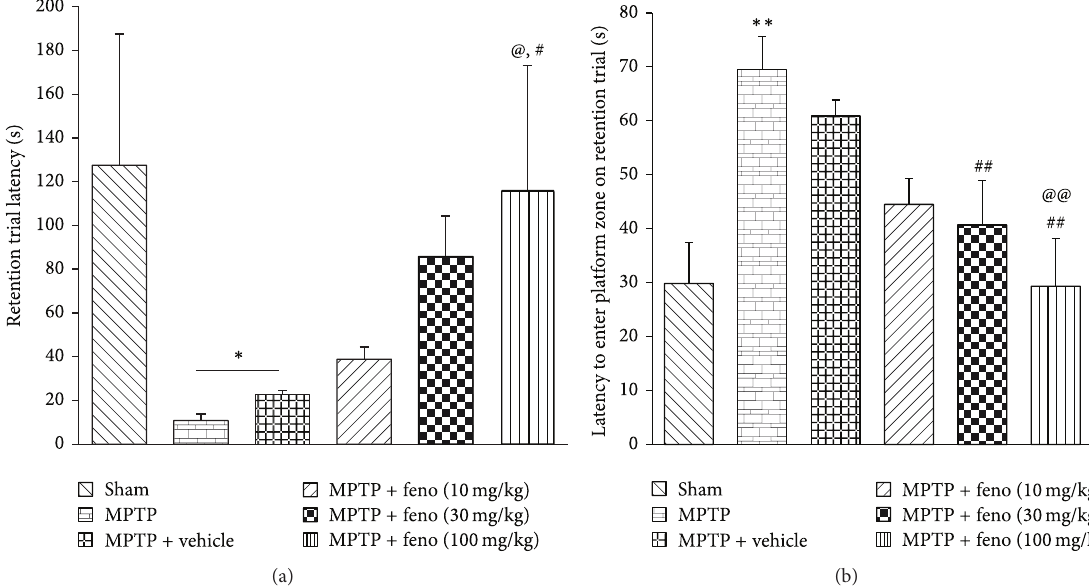
Figure 1: (a) Retention trial latency in passive avoidance test. (b) Latency to enter the platform zone during retention trial in MWM test. ∗ 𝑃 < 0.05 MPTP or MPTP + vehicle versus sham, ∗∗ 𝑃 < 0.01 MPTP versus sham, # 𝑃 < 0.05 MPTP + vehicle versus MPTP + feno 100mg/kg treated group, ## 𝑃 < 0.01 MPTP versus feno 30 mg/kg or feno 100 mg/kg treated groups, @ 𝑃 < 0.05 MPTP versus MPTP + fenofibrate 100 mg/kg, @@ 𝑃 < 0.01 MPTP + vehicle versus MPTP + feno 100mg/kg treated group. All readings are expressed as mean ± SEM ( 𝑛 = 8 to